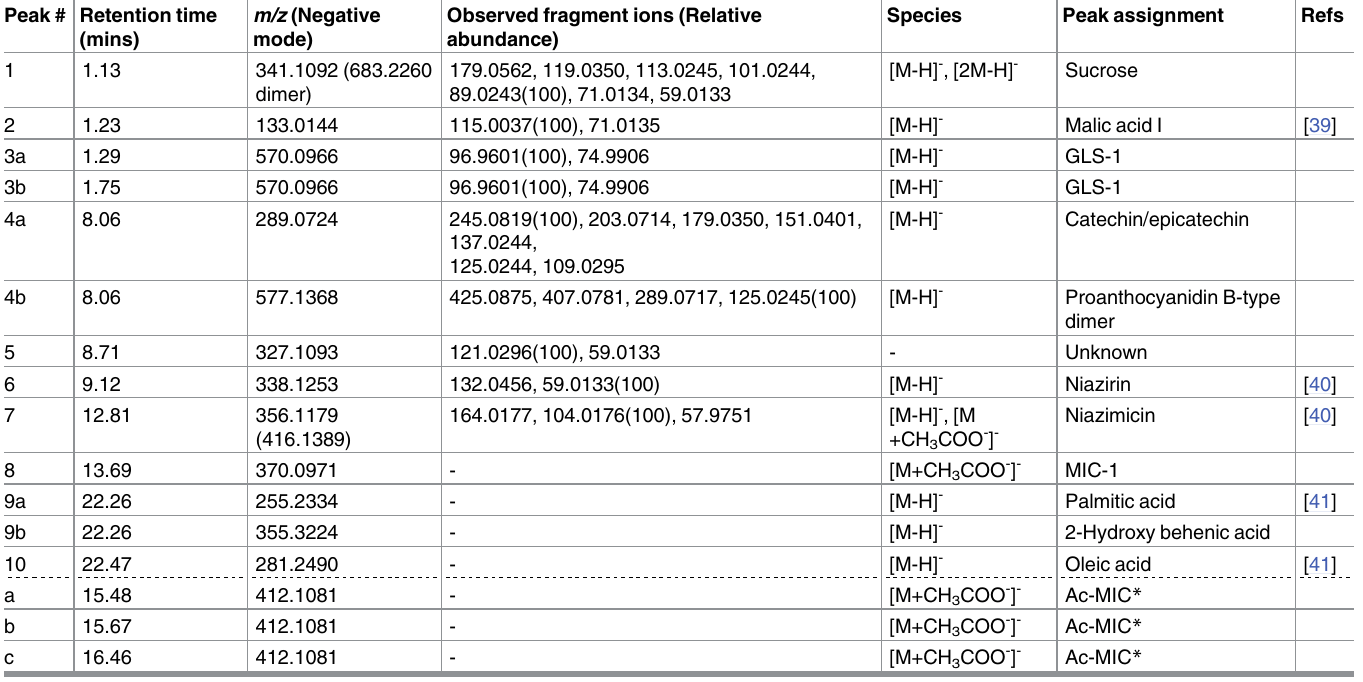
Table 2. Identification of compounds in the extract based on the